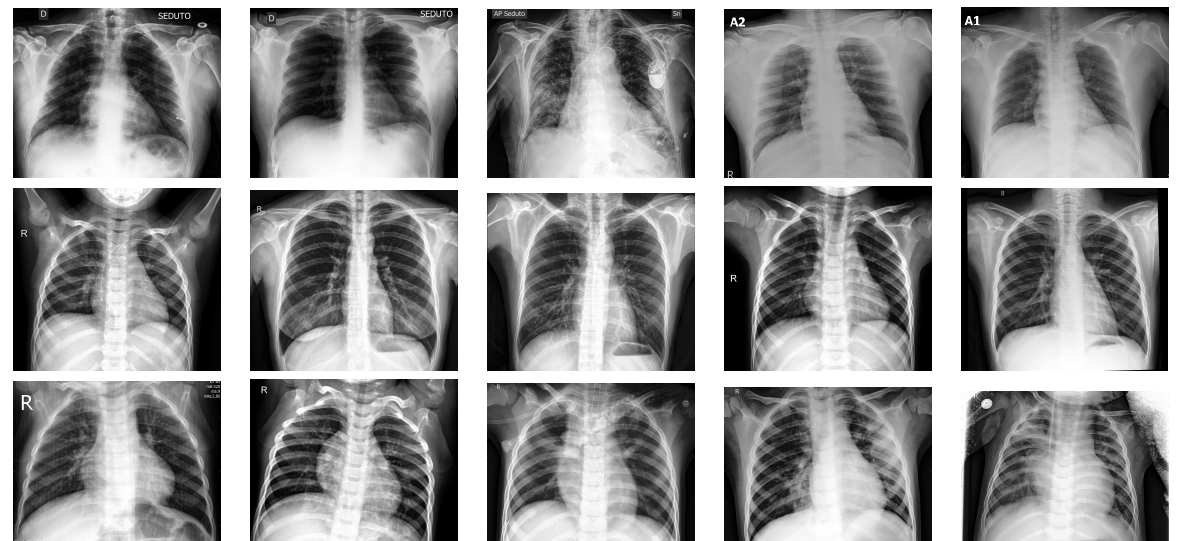
Figure 4. Sample images from the chest lesion caused by the COVID-19 infection dataset. The images are divided into three categories: Covid, Normal, and Viral Pneumonia.